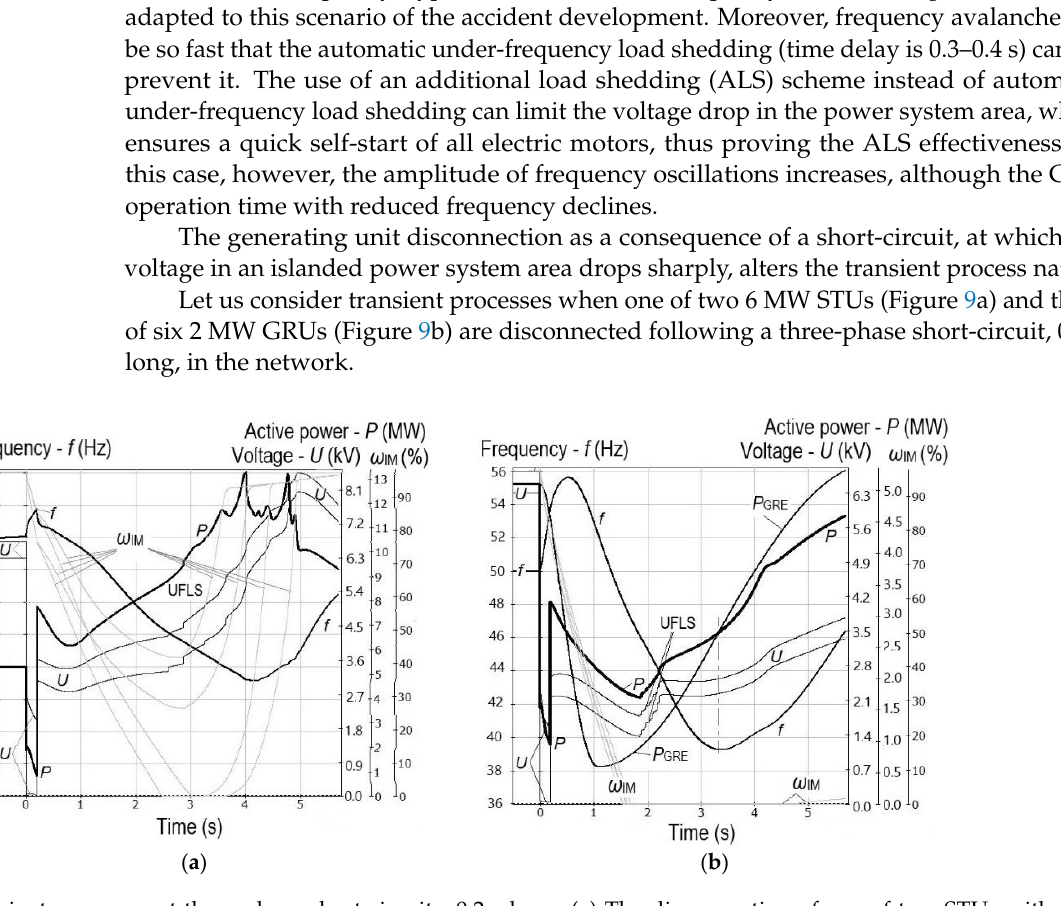
Figure 9. Transient processes at three-phase short-circuits, 0.2 s long: ( a ) The disconnection of one of two STUs with P nom = 6 MW; ( b ) The disconnection of three of six GRUs P nom = 2 MW.